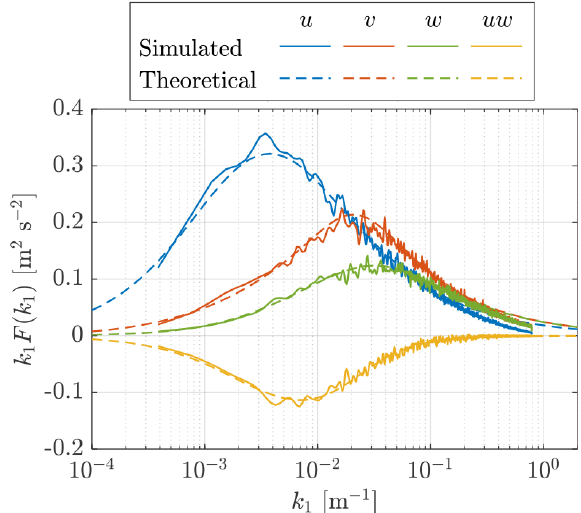
Figure 5. Comparison of the simulated and theoretical spectra of the Mann model at x = 100m in a 4D wind field. The simulated spectra are averaged with 16